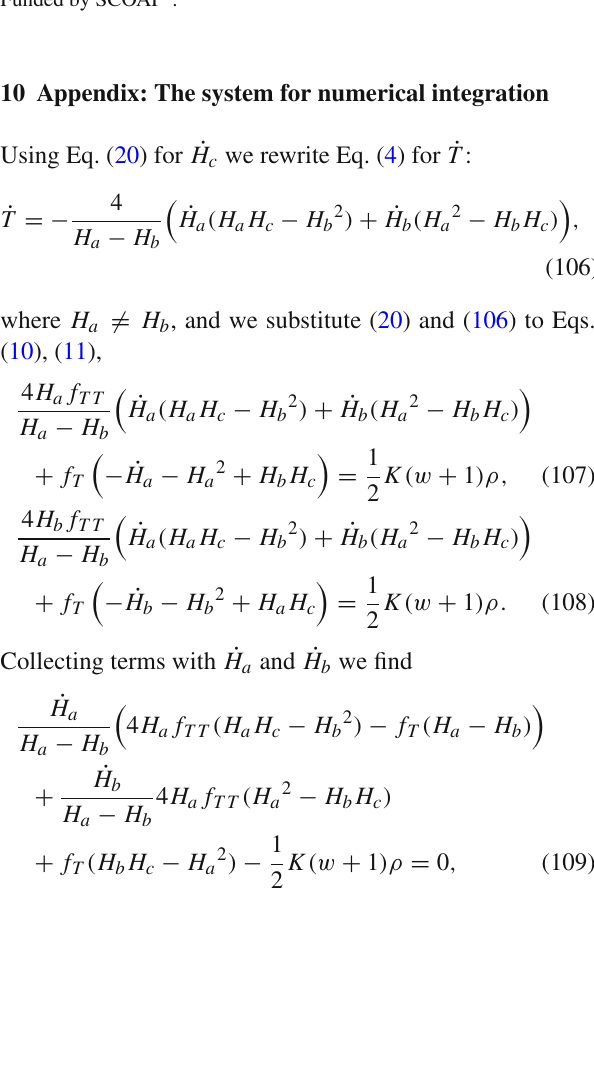
for the left picture, 5